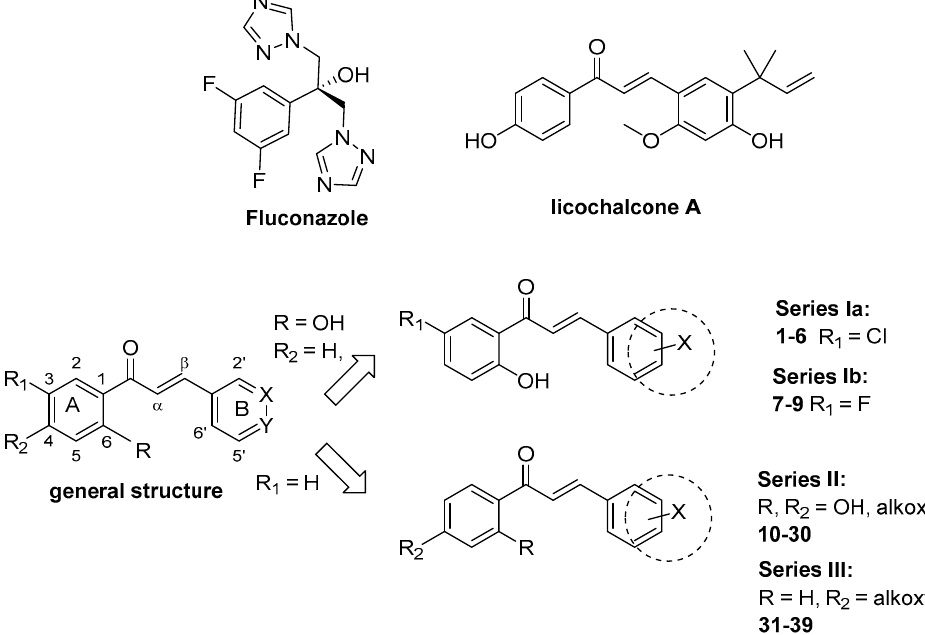
Figure 1. Structure of fluconazole, licochalcone A, and general structures of the tested chalcones.